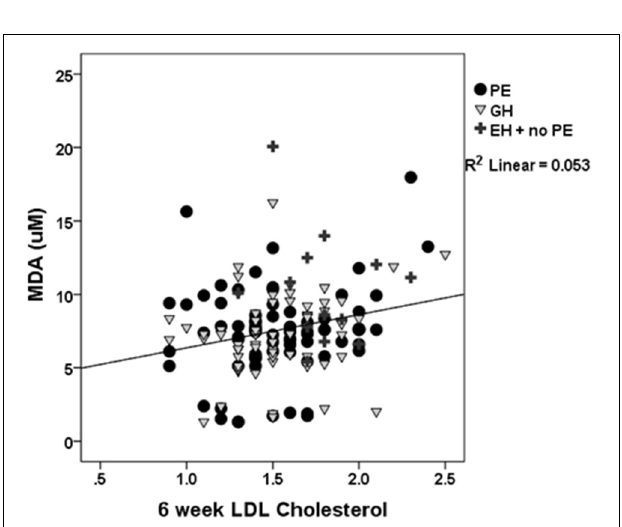
FIGURE 3 | The relationship between oxidative lipid peroxidation (TBARS-MDA) and LDL-cholesterol at 6 weeks postpartum. A significant positive association was found ( R 2 = 0 . 053, r = 0 . 23, P = 0 . 011).